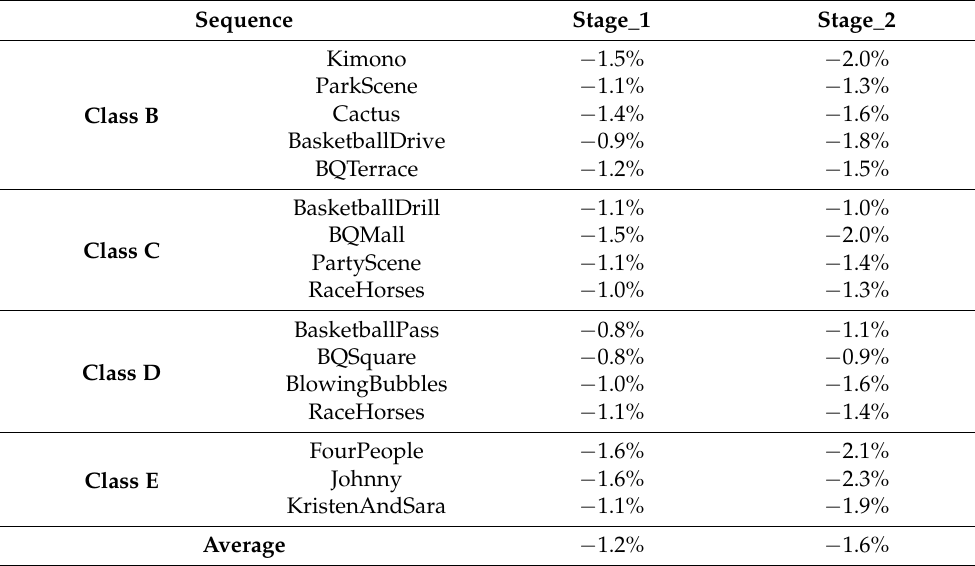
Table 4. Experimental result of our proposal compared with the anchor (HM 16.15). The coding efficiency is assessed by BD-rate